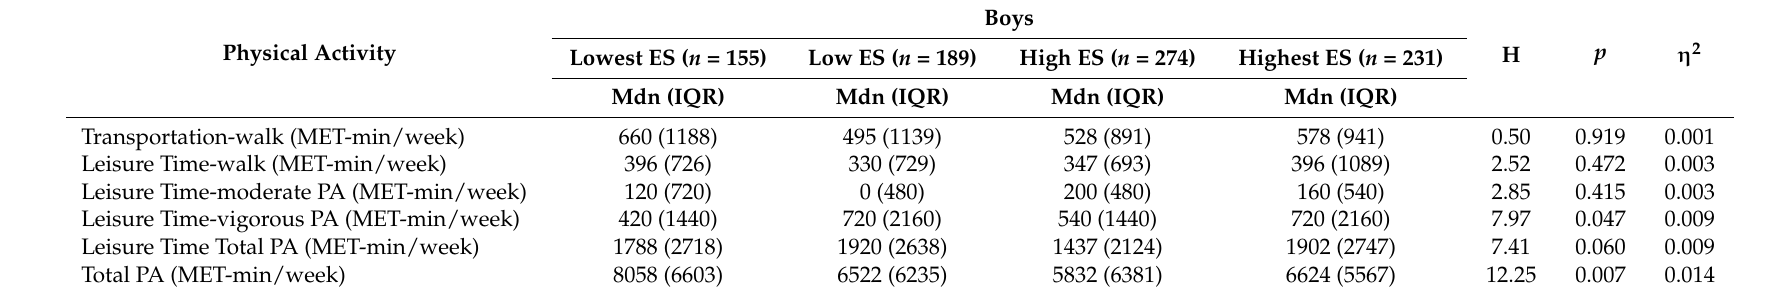
Table 2. Weekly physical activity in boys ( n = 849) by different levels of perceived neighborhood environmental safety (ES).